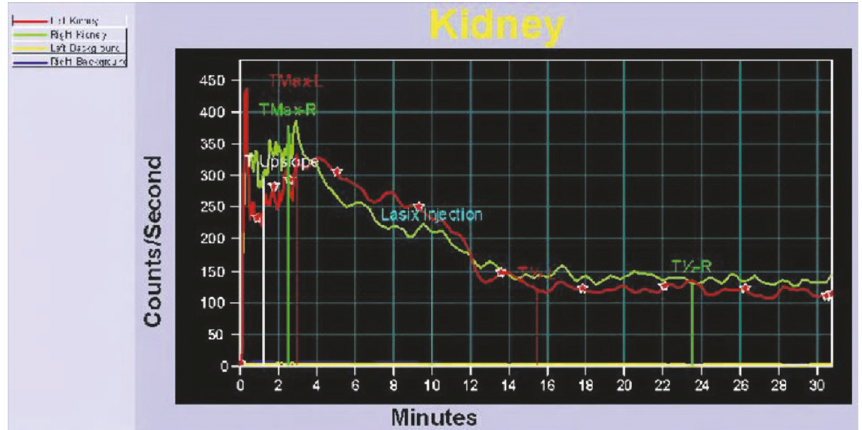
Figure 7: Renogram findings identical for left (red) and right (green) kidney: symmetrical downward slope consistent with no signs of obstruction